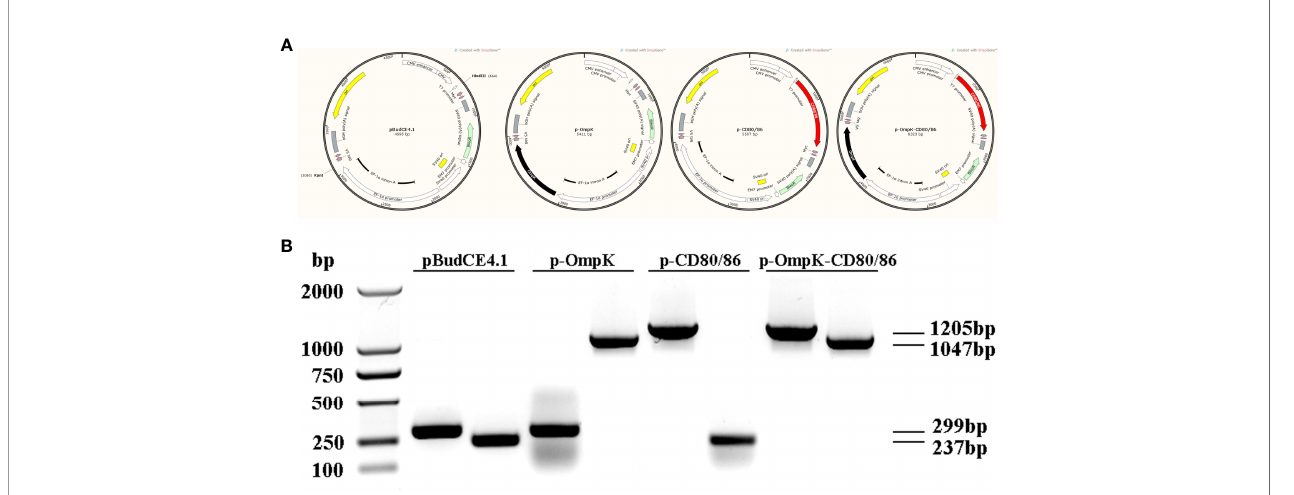
FIGURE 5 | Plasmid construction. (A) Structure of recombinant plasmids produced by Snapgene software. The CD80/86 was ligated into the Hind III site located downstream of CMV and OmpK was ligated into the Kpn I site located downstream of EF-1 a , which were represented by a red box and a black box, respectively.